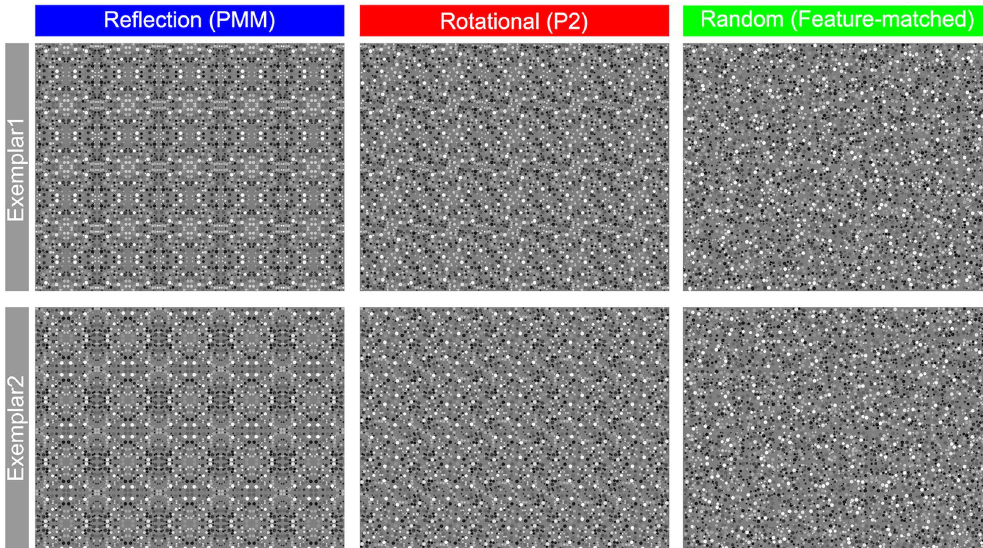
Figure 6. Experiment stimuli. Two exemplars per pattern type were used in the experiment. Rows show two exemplars of three pattern types, while columns show three pattern types used in the experiment. Note that pattern types were renamed for the ease of readers –PMM (Reflection), P2 (Rotational), feature-matched (Random). Also note that the rotational (P2) wallpaper group contains two diagonal rotational symmetry within the unit-pattern, which consists of two 180° rotations but no reflection